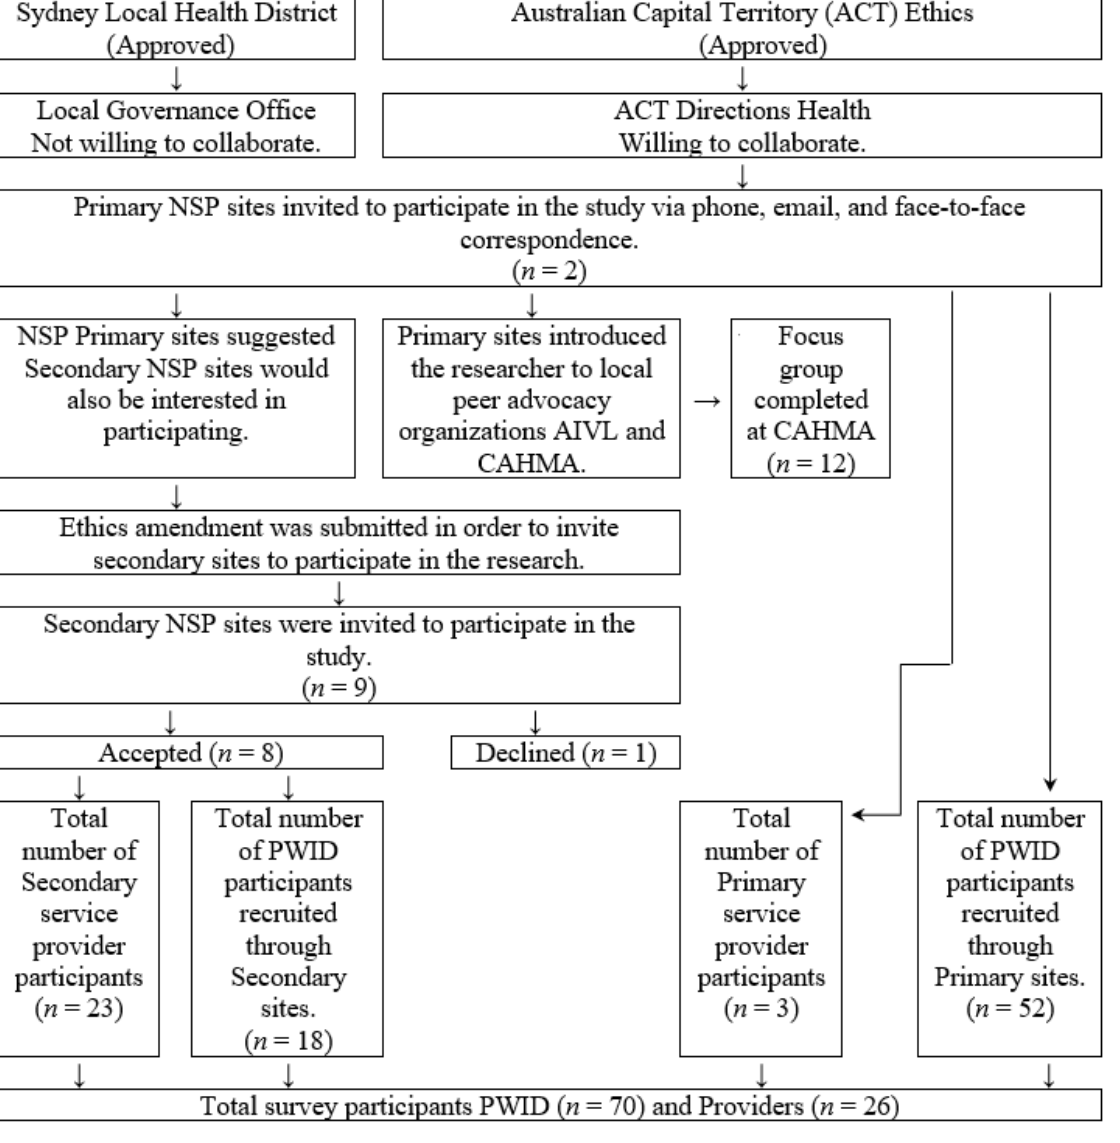
Figure 1. Flow chart of participant engagement. AIVL: The Australian Injecting and Illicit Drug Users League; CAHMA: Canberra Alliance for Harm Minimisation and Advocacy. Note: Source is author’s original work.